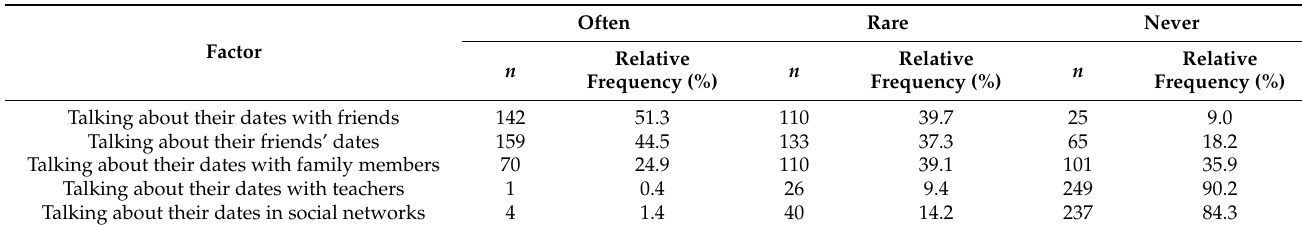
Table 3. Distributions of the respondents regarding frequency of talking about